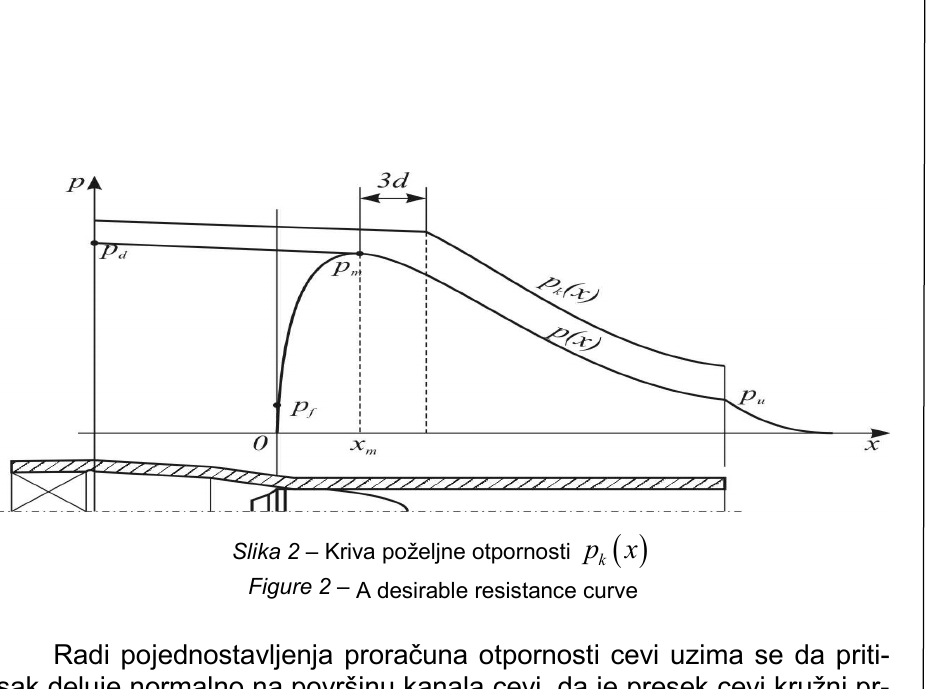
Figure 2 – A desirable resistance